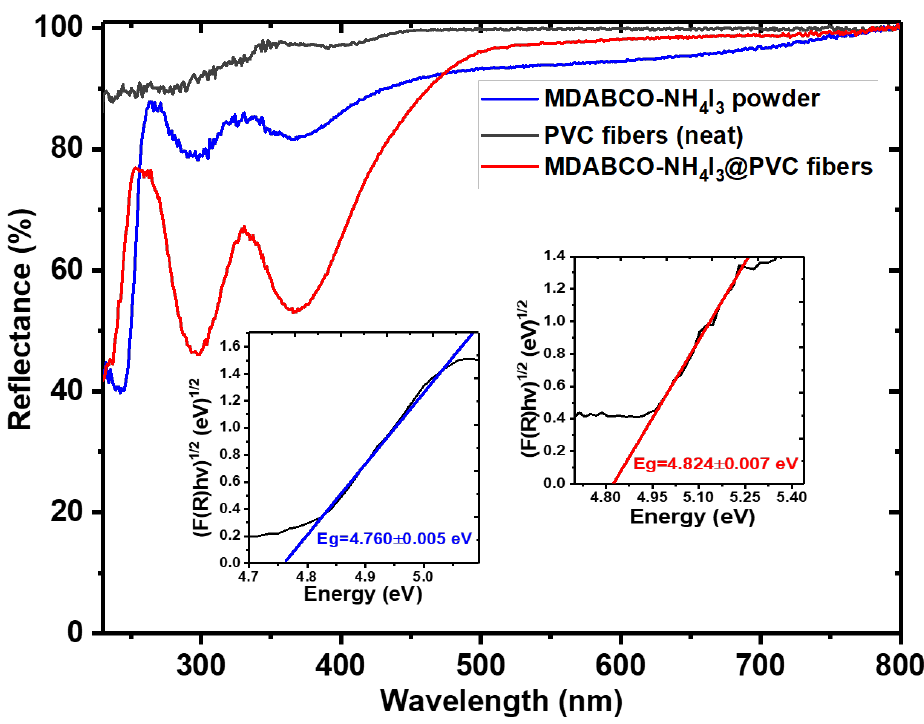
Figure 7. UV – vis reflectance of MDABCO-NH 4 I 3 powder and electrospun PVC fibers with MDABCO-NH 4 I 3 nanocrystals. The inset shows the Kubelka – Munk function indicating a band gap NH 4 I 3 nanocrystals. The inset shows the Kubelka–Munk function indicating a band gap energy of energy of 4.760 and 4.824 eV for powder and fibers, respectively. 4.760 and 4.824 eV for powder and fibers,